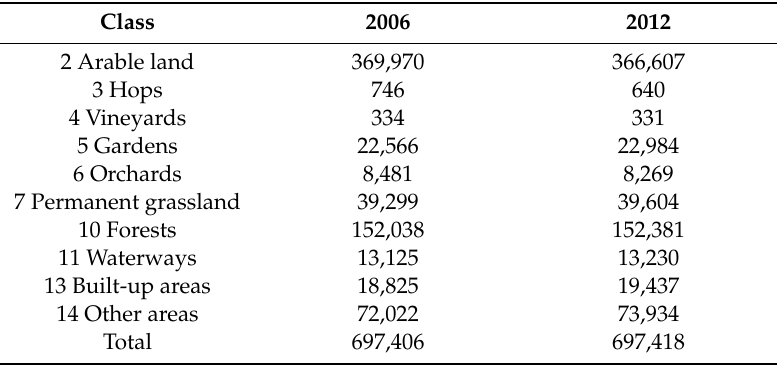
Table 7. The LU / LC in the original classes according to the KN data (in ha).